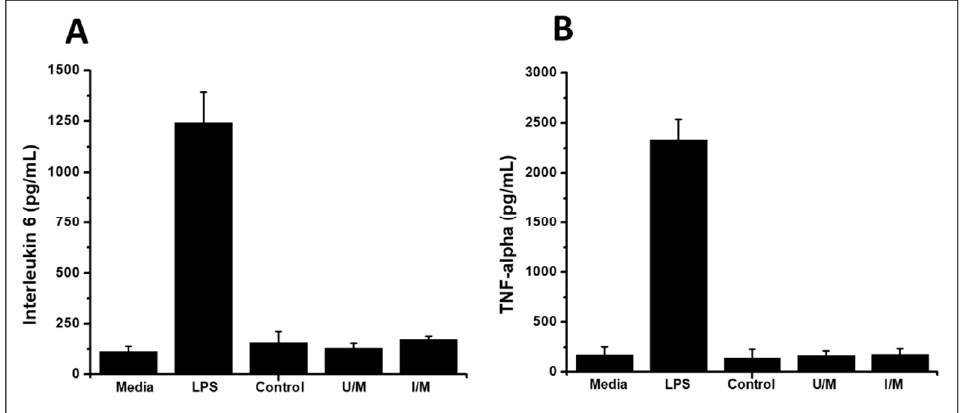
Figure 2. Expression of inflammatory molecules. ( A ) Expression of interleukin-6, ( B ) expression of TNF- α .